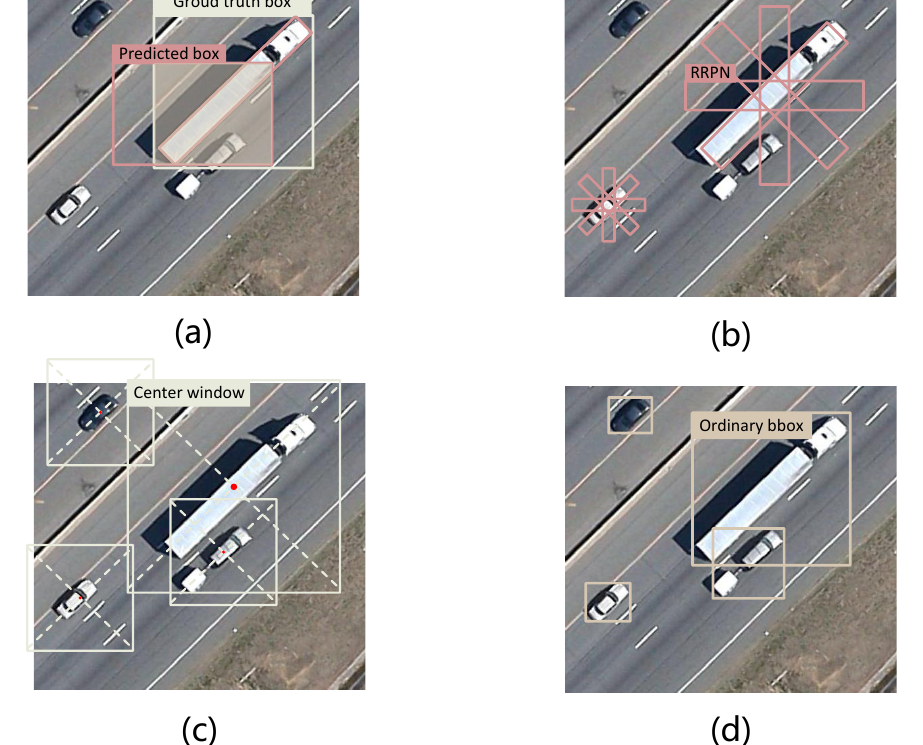
Figure 1. ( a ) The traditional anchor and ground truth matching. ( b ) The multi-angle anchor in RRPN. ( c ) The SR-Net-proposed center window. ( d ) The ordinary